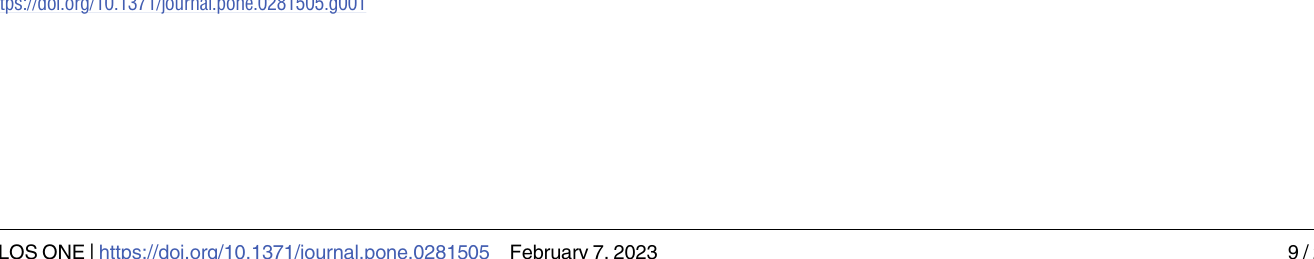
PLOS ONE | https://doi.org/10.1371/journal.pone.0281505 February 7,